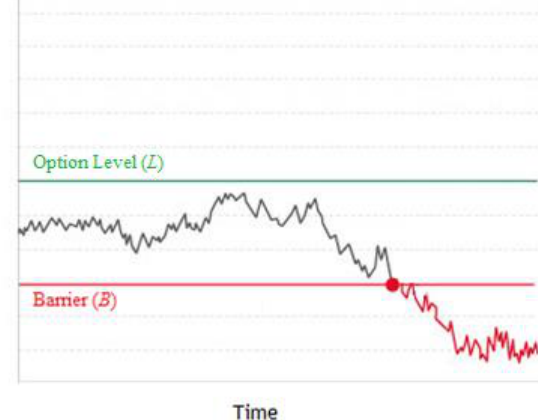
Figure 3. Underlying asset below the barrier